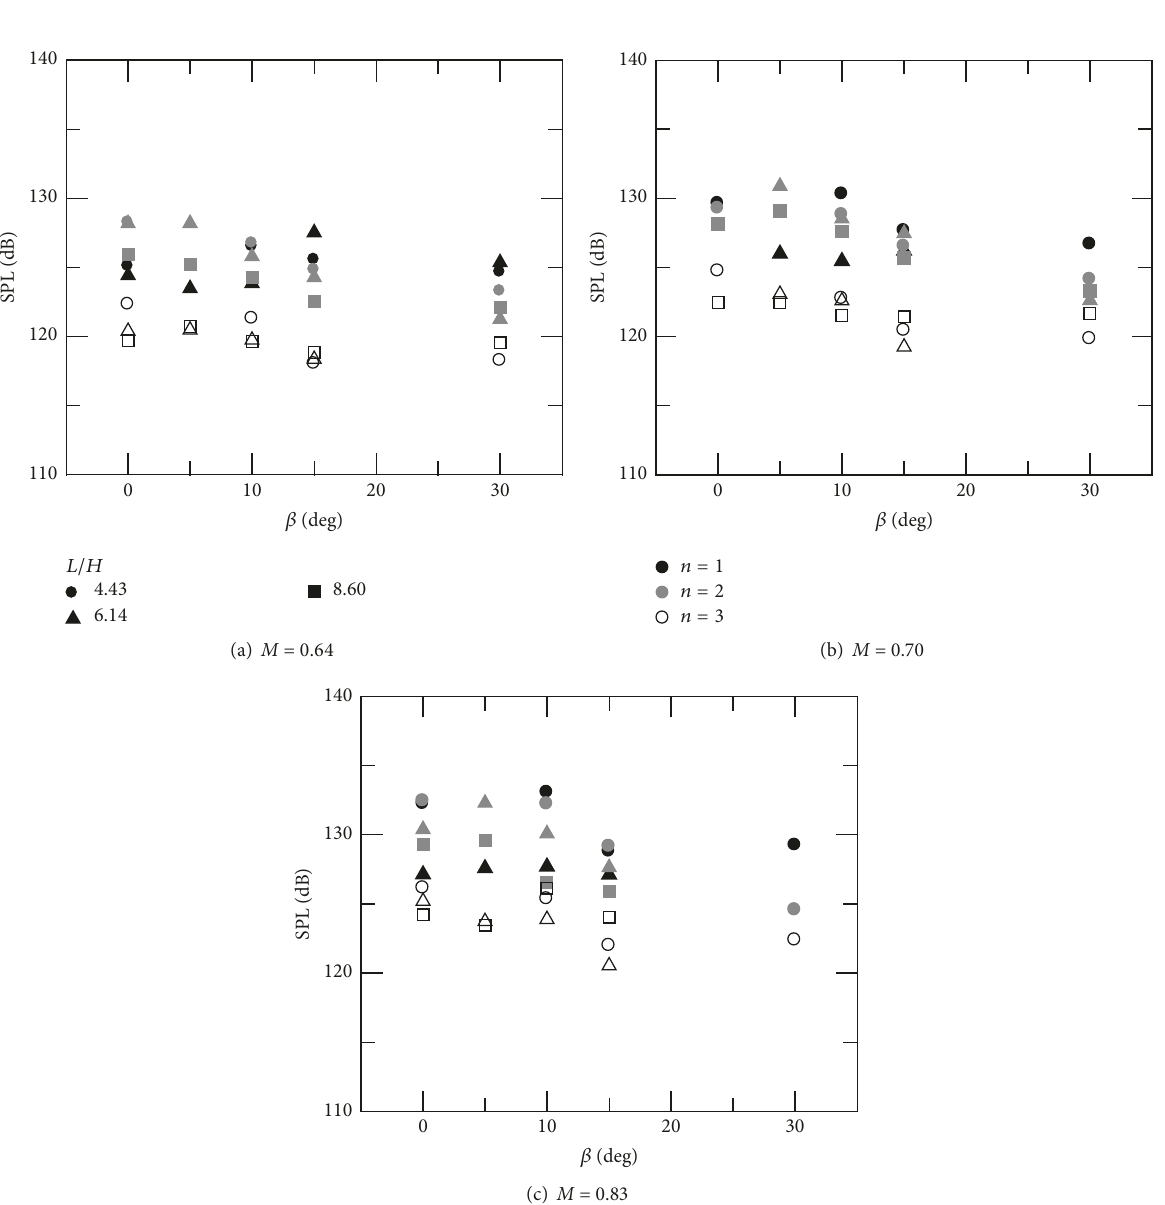
Figure 12: Amplitude of the resonant modes: (a) M = 0.64, (b) M = 0.70, and (c) M =